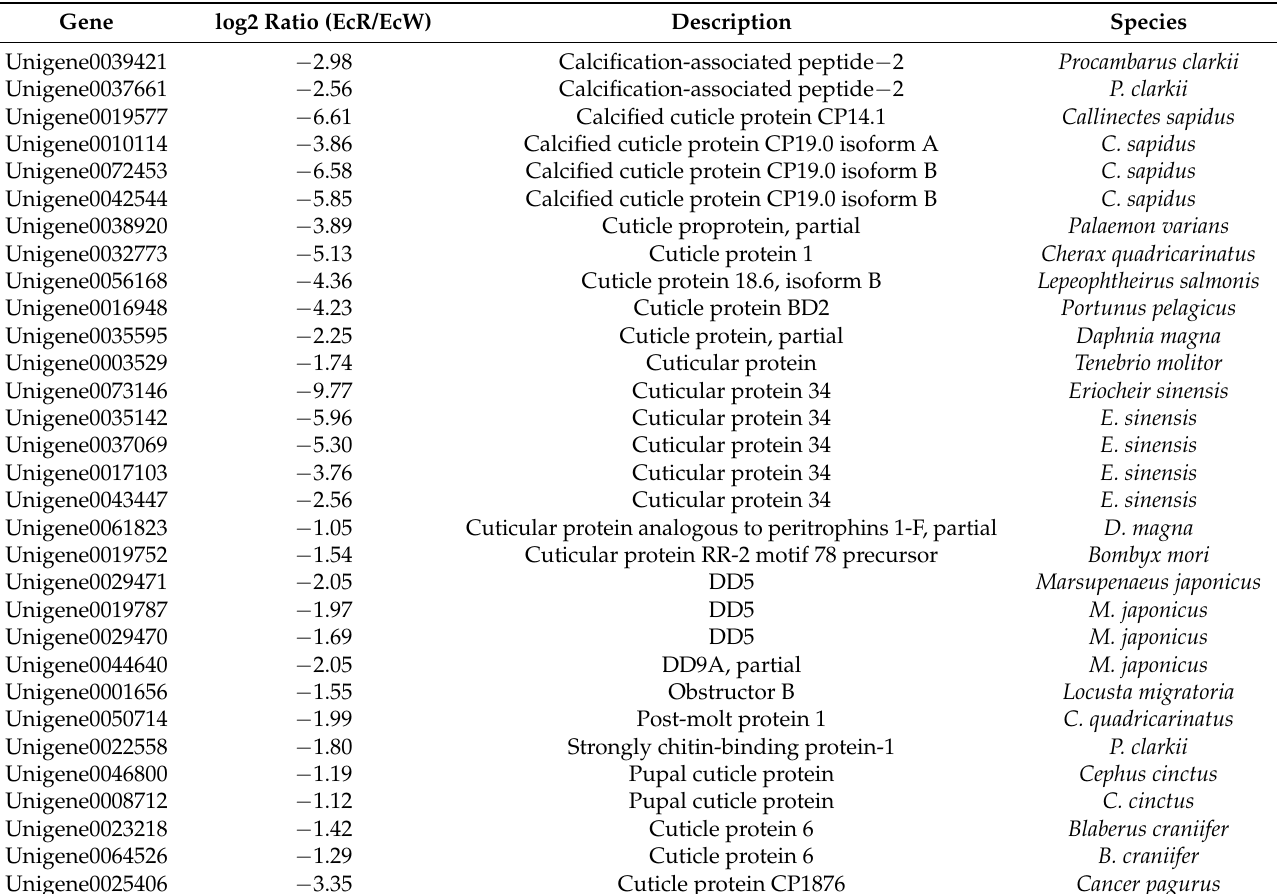
Table 3. Information of cuticular proteins in DEGs.